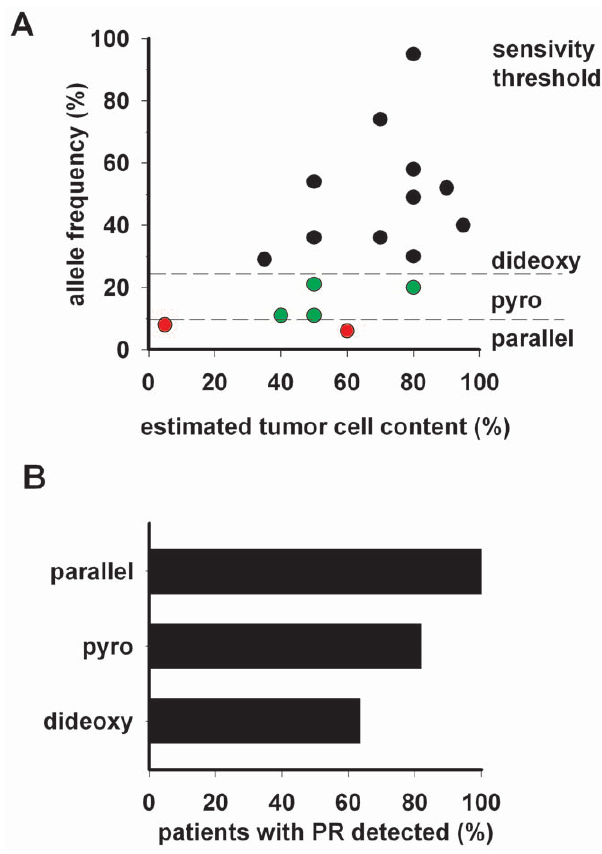
Figure 2. Mutation detection performance in NSCLC tumor samples using dideoxy sequencing, pyrosequencing and massively parallel sequencing. (A) Correlation between the estimated tumor cell content and the actual frequency of mutated alleles determined by massively, parallel sequencing data. Black, mutations detected by dideoxy and pyrosequencing; Green, mutations detected by pyrosequencing, but missed by dideoxy sequencing; Red, mutations only detected by parallel sequencing. (B) Sensitivity of dideoxy sequencing, pyrosequencing and massively parallel sequenc- ing in patients with confirmed clinical response to treatment with erlotinib.